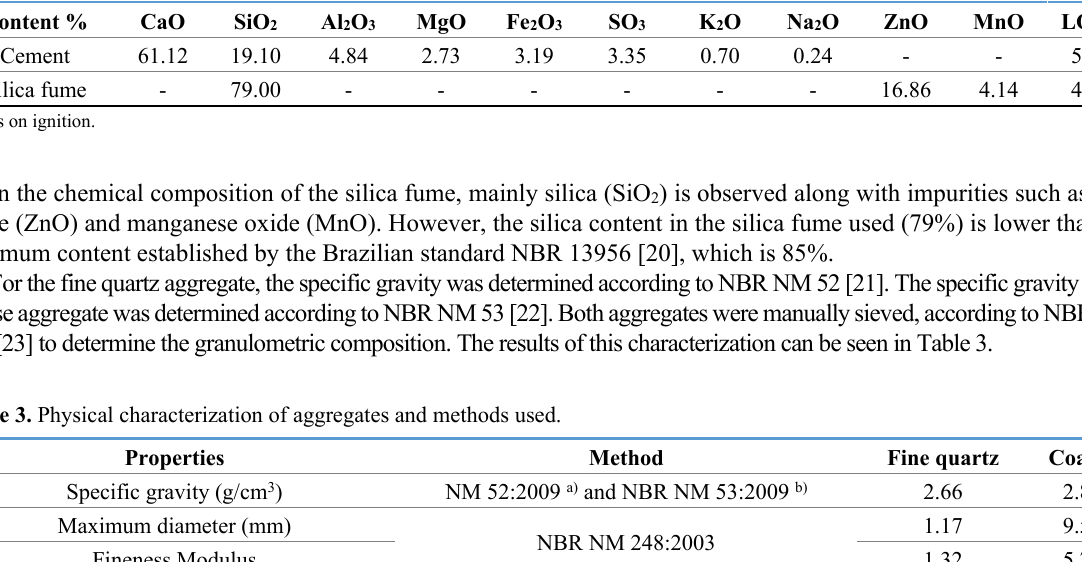
Table 2. Chemical compositions of cement and silica fume used, in oxides.